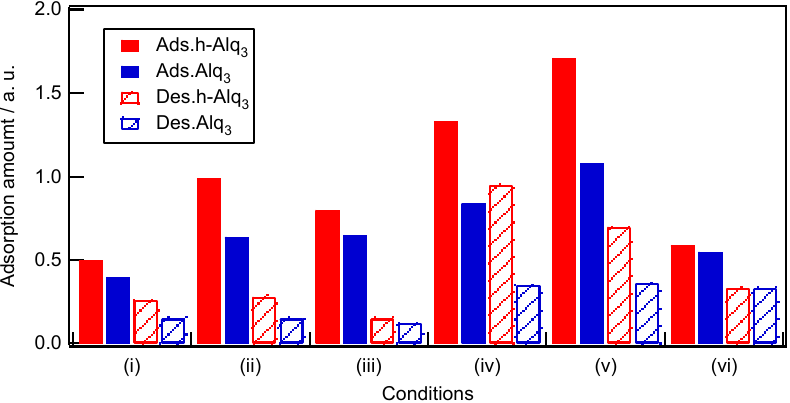
Figure 10. Relative adsorbed amounts of Alq 3 and h-Alq 3 on various APA surfaces obtained after immersion in 1 mM Alq 3 /EtOH and HQ/EtOH solutions for 30 min, respectively, and after treatment with water for 30 min.